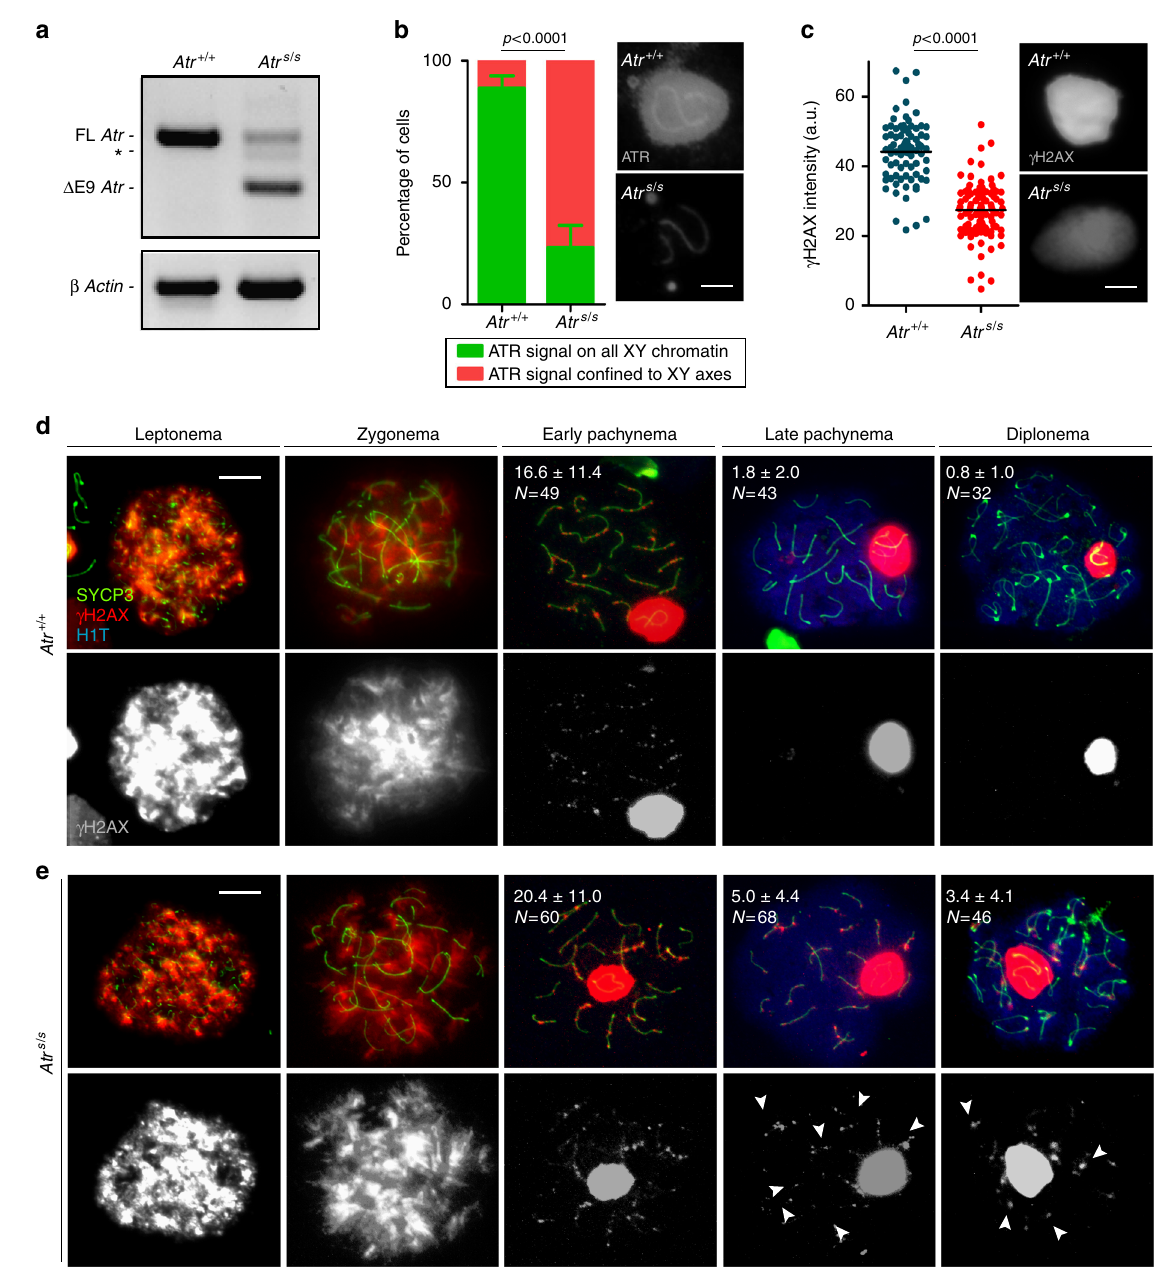
Fig. 1 Seckel mouse spermatocytes exhibit more γ H2AX patches than wild-type cells. a RT-PCR using primers that anneal to Atr exons 8 and 10. Atr S/S testis exhibits two main RT-PCR products, one corresponding to full-length Atr (FL Atr , 477 bp), which is substantially reduced, and another corresponding to Atr lacking exon 9 ( Δ E9 Atr , 284bp). Asterisk denotes RT-PCR product resulting from the use of a cryptic splice donor site 16 . RT-PCR for β Actin is also provided as a control. b Percentage of cells exhibiting ATR staining extended to X and Y chromatin or con fi ned to the X and Y chromosome axes in Atr + / + and Atr S/S ( N = 284 and N = 282, respectively). Columns and lines indicate the mean and standard deviation (SD) from analysis performed on three wild- type and three mutant mice. Images show ATR straining on the sex body in Atr + / + and Atr S/S pachytene spermatocytes. Images were captured with the same exposure time. Scale bar = 2 μ m. c Quanti fi cation of the intensity of γ H2AX staining on the sex body in arbitrary units (a.u.). Horizontal black lines denote the means. Images show representative sex bodies from Atr + / + and Atr S/S pachytene spermatocytes immunostained against γ H2AX. Images were captured with the same exposure time. Scale bar = 2 μ m. Representative images of Atr + / + ( d ) and Atr S/S ( e ) spermatocytes at different stages of meiotic prophase immunostained against SYCP3, γ H2AX, and H1T. Scale bars = 10 μ m. Numbers represent the mean ± SD of γ H2AX patches found in each stage and genotype. N denotes the number of cells analyzed. H1T incorporation marks spermatocytes after mid-pachynema 62 . Arrowheads indicate examples of aberrant autosomal γ H2AX patches in Atr S/S spermatocytes. The differences between controls and Atr S/S for γ H2AX patch numbers at late pachynema and diplonema were statistically signi fi cant ( p = 0.0001 and p = 0.0007, respectively, t